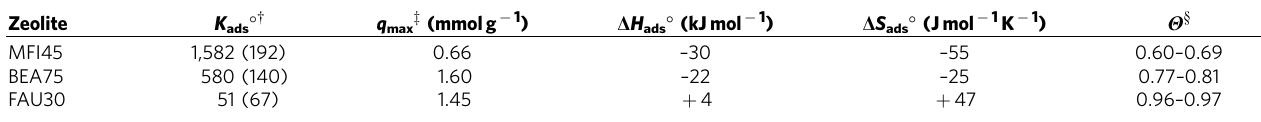
*AdsorptionconstantswerederivedfromtheslopeofthelinearizedLangmuirisotherm,standardmolarenthalpychangesofcyclohexanoladsorptionweredeterminedbymicrocalorimetry( o 60%ofthe saturation uptake) and variable-temperature isotherm measurements and standard molar entropy changes were obtained from D G ads (cid:2) ¼ (cid:4) RT ln K ads (cid:2) ¼ D H ads (cid:2) (cid:4) T D S ads (cid:2) that relates all thermodynamic quantities. Standard states for aqueous and adsorbed molecules are 1moll (cid:4) 1 and intrazeolitic void occupancy ¼ 1, respectively. w Adsorption constants at 280K (outside the brackets) and 333K (in the brackets). z Saturation uptake at 298K. y Predicted fractional uptake ( q / q max ) at 423–443K, 0.33M aqueous solution of cyclohexanol.